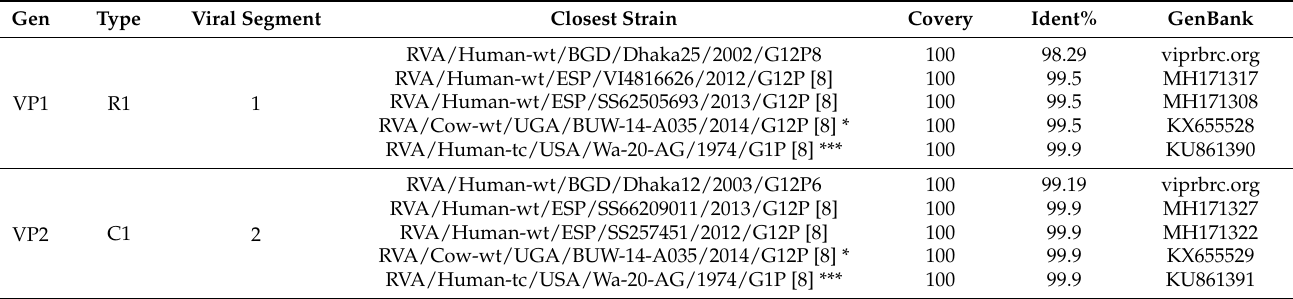
Table 1. Prototype strains of each genotype by using BLAST™ and the RotaC v2.0 in ViPR. Gen Type Viral